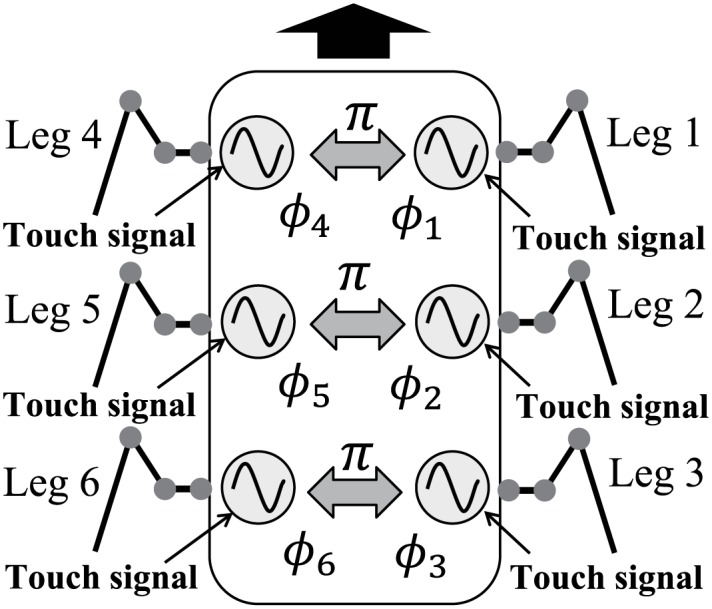
Locomotion control system using phase oscillators.Each oscillator controls the movement of a single leg. Contralateral oscillators are set to have alternate phases. Each oscillator is affected by the touch sensor signal.